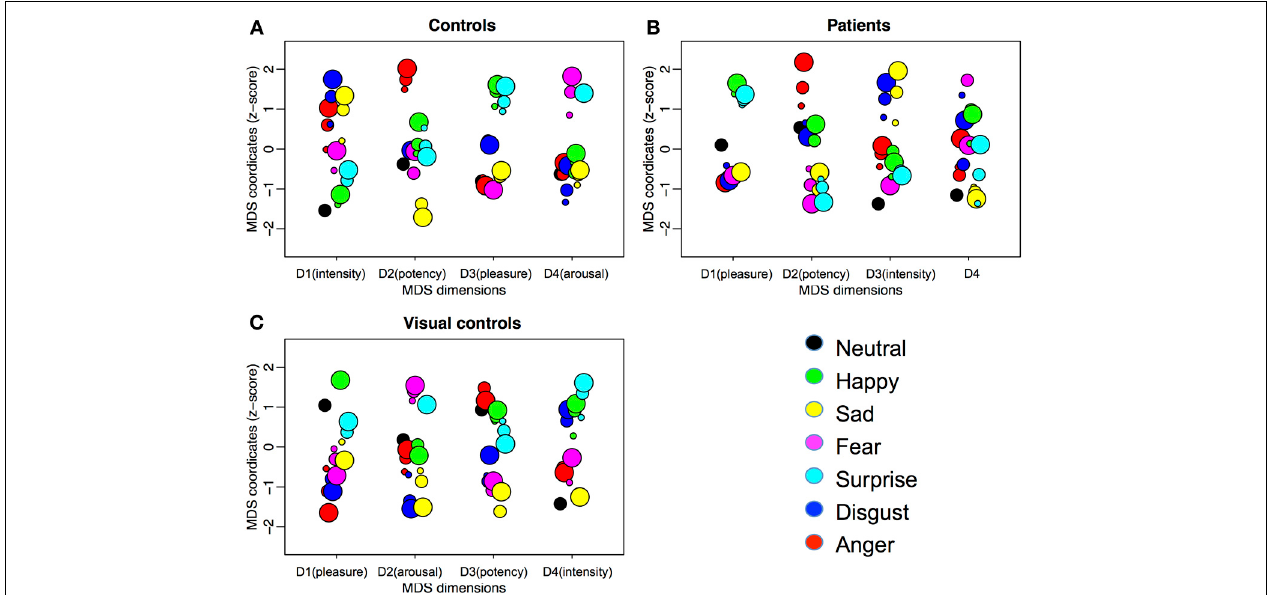
FIGURE 4 | Four-dimensional MDS solutions for (A) controls, (B) patients treated for congenital bilateral cataracts, and (C) visual controls. We ordered the dimensions by the amount of variance explained by them from high (D1) to low (D4). Each dimension is plotted in isolation with the horizontal